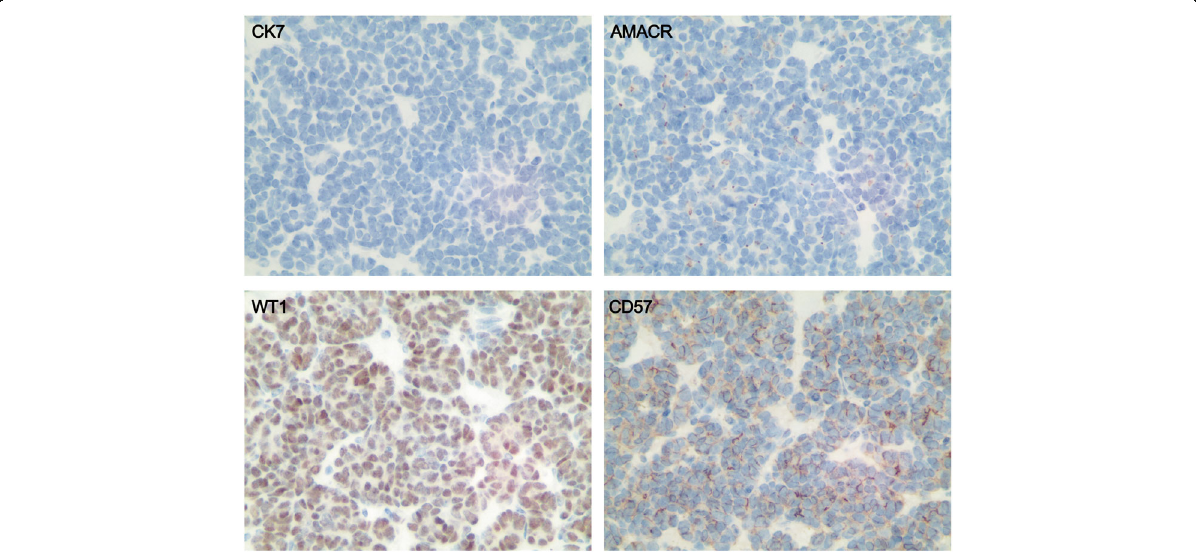
Fig. 3 Immunohistochemical staining for pathological markers CK7, AMACR, WT1 and CD57 (400×) in representative MA tissues. The staining of positive tumor cells ranged from 1+ to 3+, indicating diffuse, moderate, and strong cytoplasmic